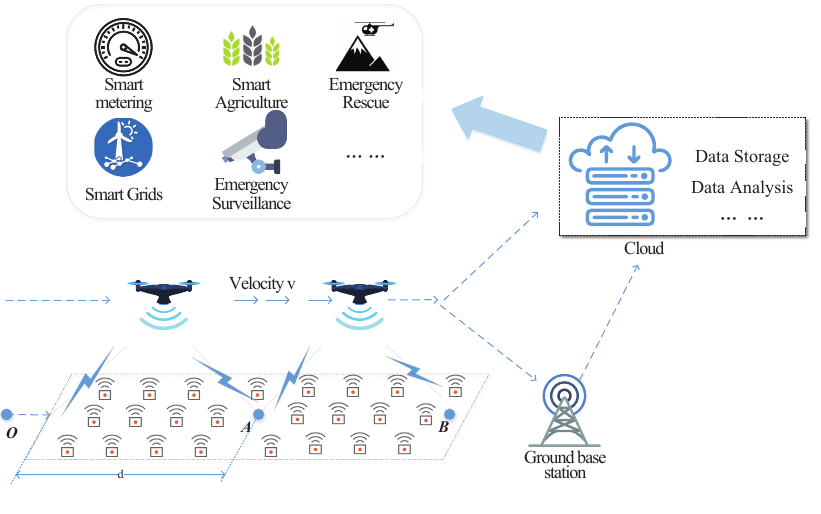
Figure 1. Data collections via